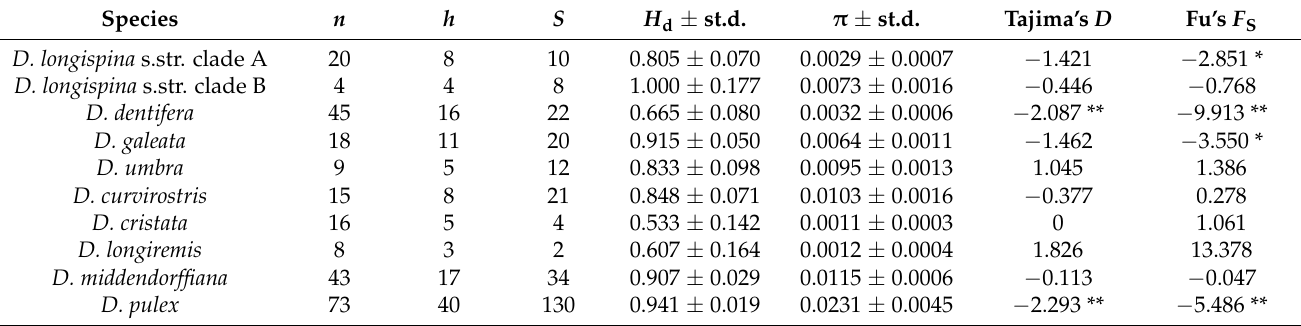
Table 2. Polymorphism of the 12S gene fragment of mtDNA for Daphnia species and neutrality tests based on original sequences only. Note: n —number of sequences used; S —polymorphic (segregating) sites; h —number of haplotypes; H d —haplotype (gene) diversity; π —nucleotide diversity; st.d.— standard deviation; * p < 0.05, *** p < 0.001.